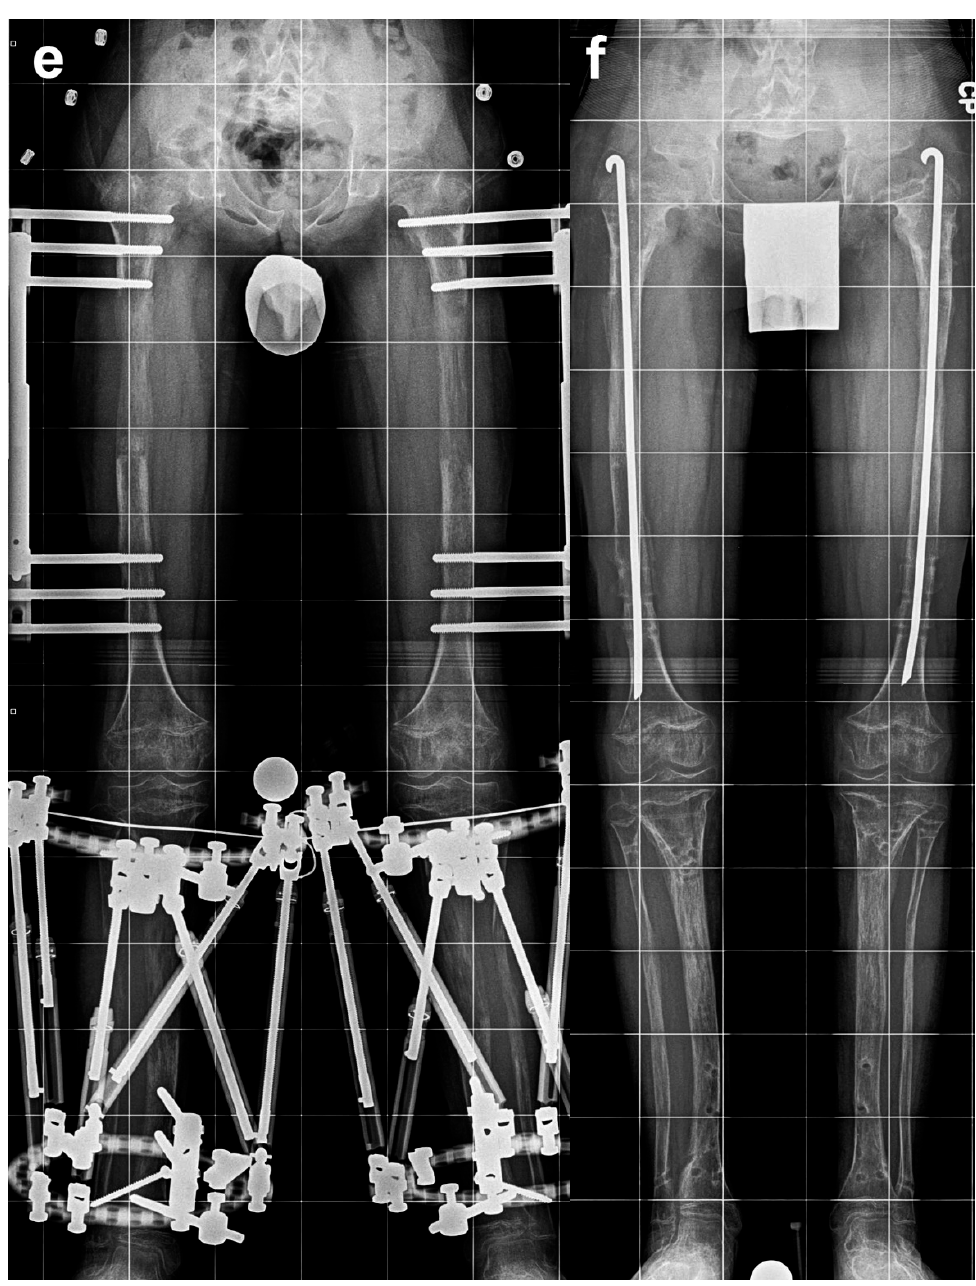
Figure 2. Eight-year-old boy who underwent two simultaneous bilateral femoral tibial lengthening (SBFTL) procedures. A Taylor Spatial Frame (Smith & Nephew, London, UK) was used for the tibia, and an Orthofix LRS (Lewisville, TX) was used for the femur. ( a ) Prior to first limb lengthening. ( b ) During first SBFTL. ( c ) Status after 10-cm lengthening. ( d ) Prior to second limb lengthening. ( e ) During second SBFTL. ( f ) Status after additional 12.5-cm lengthening (used with permission).